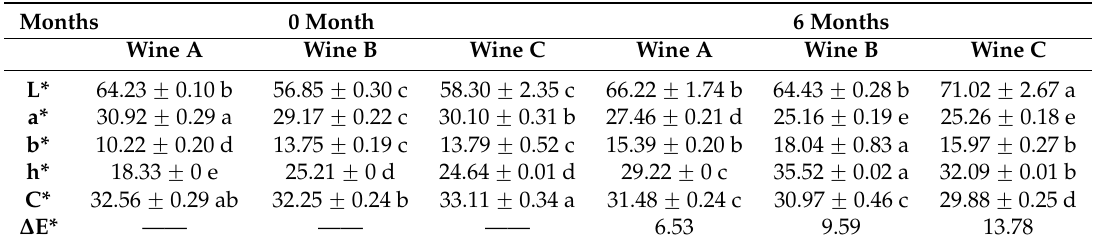
Table 3. The color parameters of fresh (0 month) and bottle-aged (6 months) bog bilberry syrup